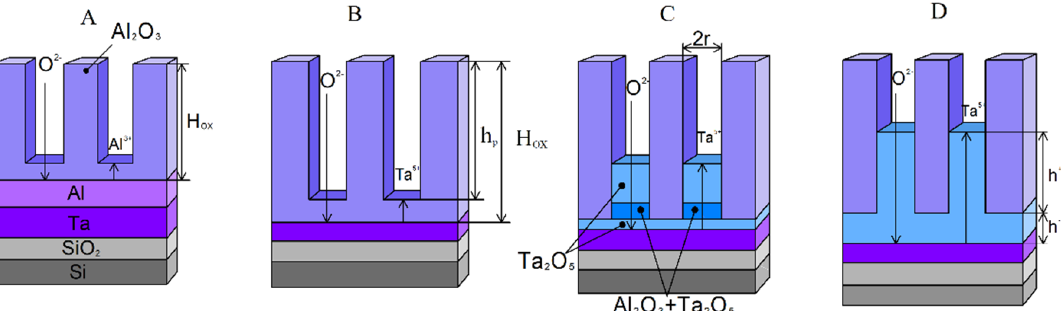
Figure 2. Schematic diagram of the main steps for nanopillars forming from Al/Ta metal sputter ‐ deposited layers on a Si substrate: ( A ) porous anodizing of the Al film to a certain depth; ( B ) porous anodization of the Al film to Ta film; ( C ) anodization of a Ta layer at the Al anodizing voltage (U Al ); ( D ) formation of Ta 2 O 5 pillars at Ta anodizing voltage (U Ta ).